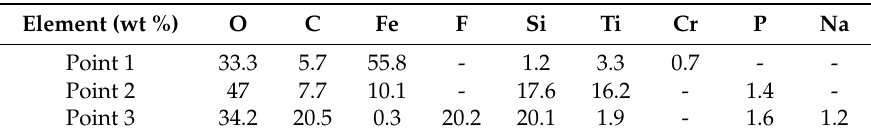
Figure 8. Micro worn morphologies after a sliding distance of 100 m under the load of 4 N: ( a ) PEO TiO 2 coating; ( b ) the self-lubricating PEO–PTFE composite coating. Table 2. Element composition of the PEO TiO 2 coating and PEO–PTFE composite coating worn track after a sliding distance of 100 m under 4 N in Figure